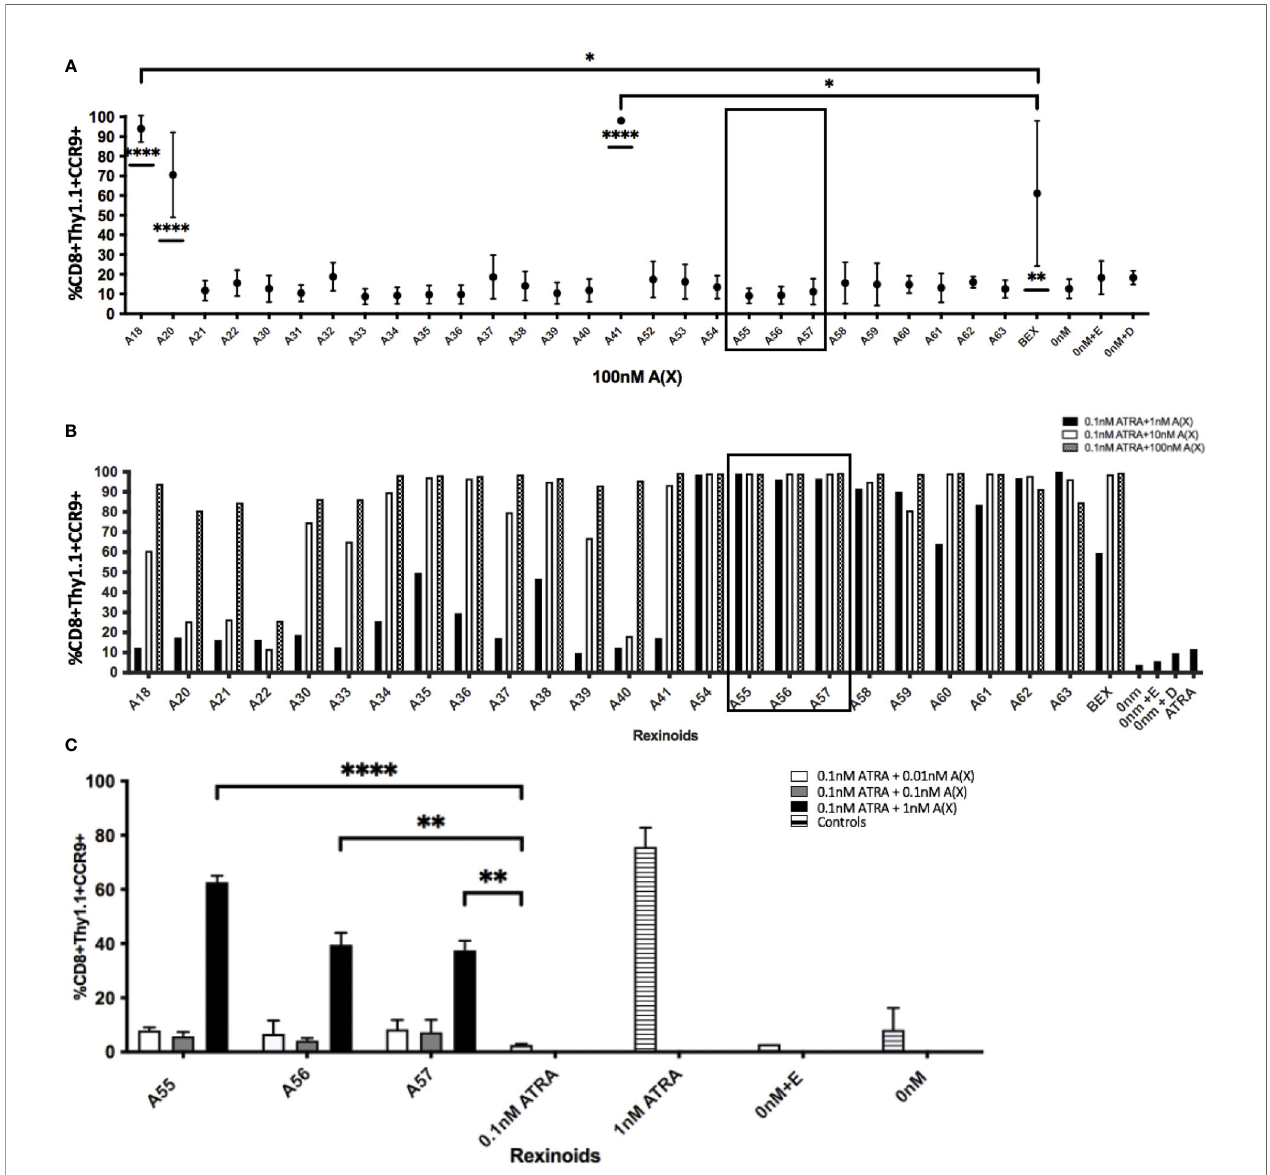
FIGURE 4 | Rexinoids can enhance effector CD8+ T cell expression of CCR9 independently or in combination with ATRA. Splenocytes obtained from P14 mice were stimulated with GP 33-41 peptide and cultured either with 100nM rexinoids in vitamin A de fi cient media (top), or in vitamin A de fi cient media supplemented with suboptimal doses of rexinoids and ATRA. After 8 day culture, effector CD8+ T cells were analyzed for expression of CCR9 using fl ow cytometry. (A) Rexinoids A18, A20, A41 and BEX are able to signi fi cantly enhance CCR9 expression independent of ATRA presence, compared to no treatment. Rexinoids A18 and A41 also signi fi cantly enhance CCR9 expression, compared to BEX. Experiment performed in triplicate. Connecting letters report used to determine statistical signi fi cance, with ordered differences report used to compare p-values between groups (* = p < 0.05, ** = p < 0.005, **** = p < 0.0001). (B) Suboptimal doses of several rexinoids cooperate with suboptimal doses of ATRA to enhance CCR9 expression. Boxed region identi fi es rexinoids that had minimal effect on CCR9 expression when previously delivered at 100nM. (boxed region 3A; graph representative of one experiment). (C) Replicate data obtained from culturing cells with suboptimal doses of rexinoid and ATRA. Rexinoids selected were those that showed high cooperativity with ATRA from 3B (boxed region). Suboptimal doses of selected rexinoid combined with suboptimal ATRA signi fi cantly improved CCR9 expression, compared to suboptimal ATRA alone (** = p < 0.005, **** = p < 0.0001). Rexinoid dosages lower than 1nM did not result in enhanced CCR9 expression. Experiment performed in triplicate. All error bars represent SD from the